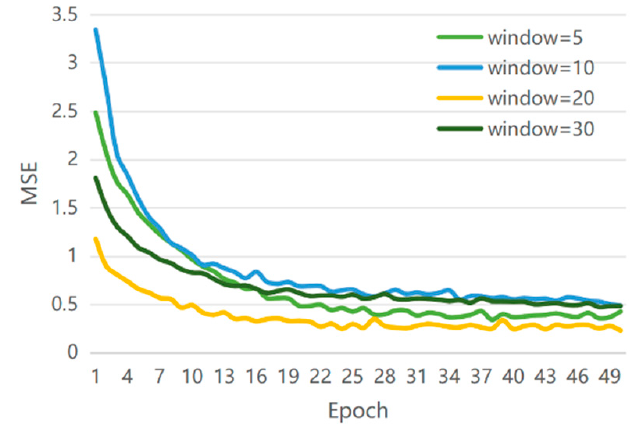
Figure 6. Time window selection.